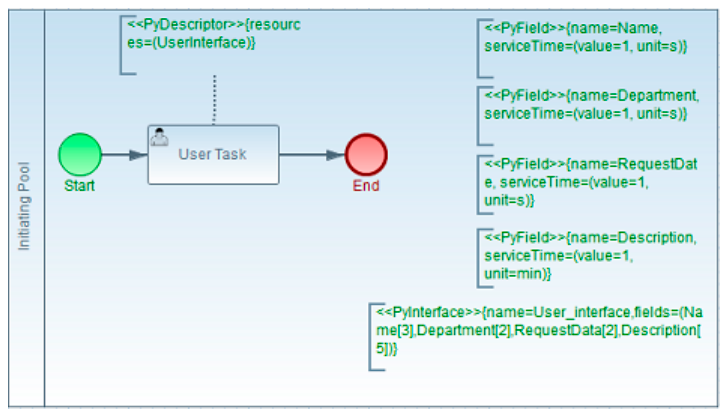
Figure 9. Example of PyInterface in use.